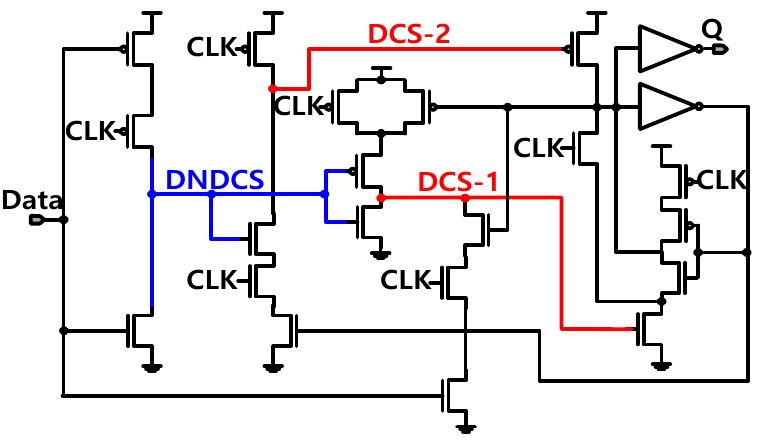
Figure 6. Circuit Diagram of Proposed Dual Change-Sensing Flip-Flop (DCSFF).